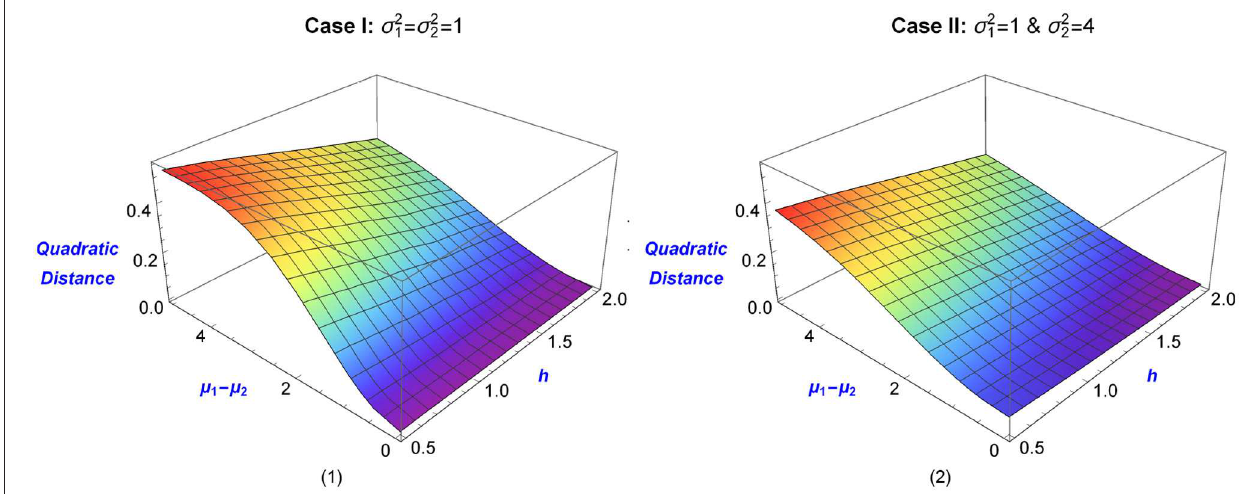
µ 2 . Graph (1) shows the −